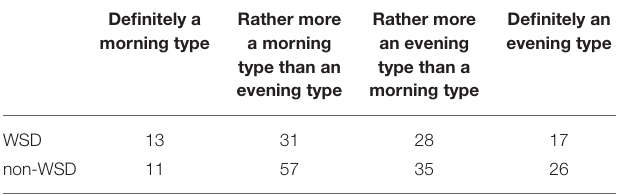
TABLE 3 | The participants distribution in item 19 of MEQ. TABLE 4 | Comparison of questionnaires (significance level with the Bonferroni correction: p <